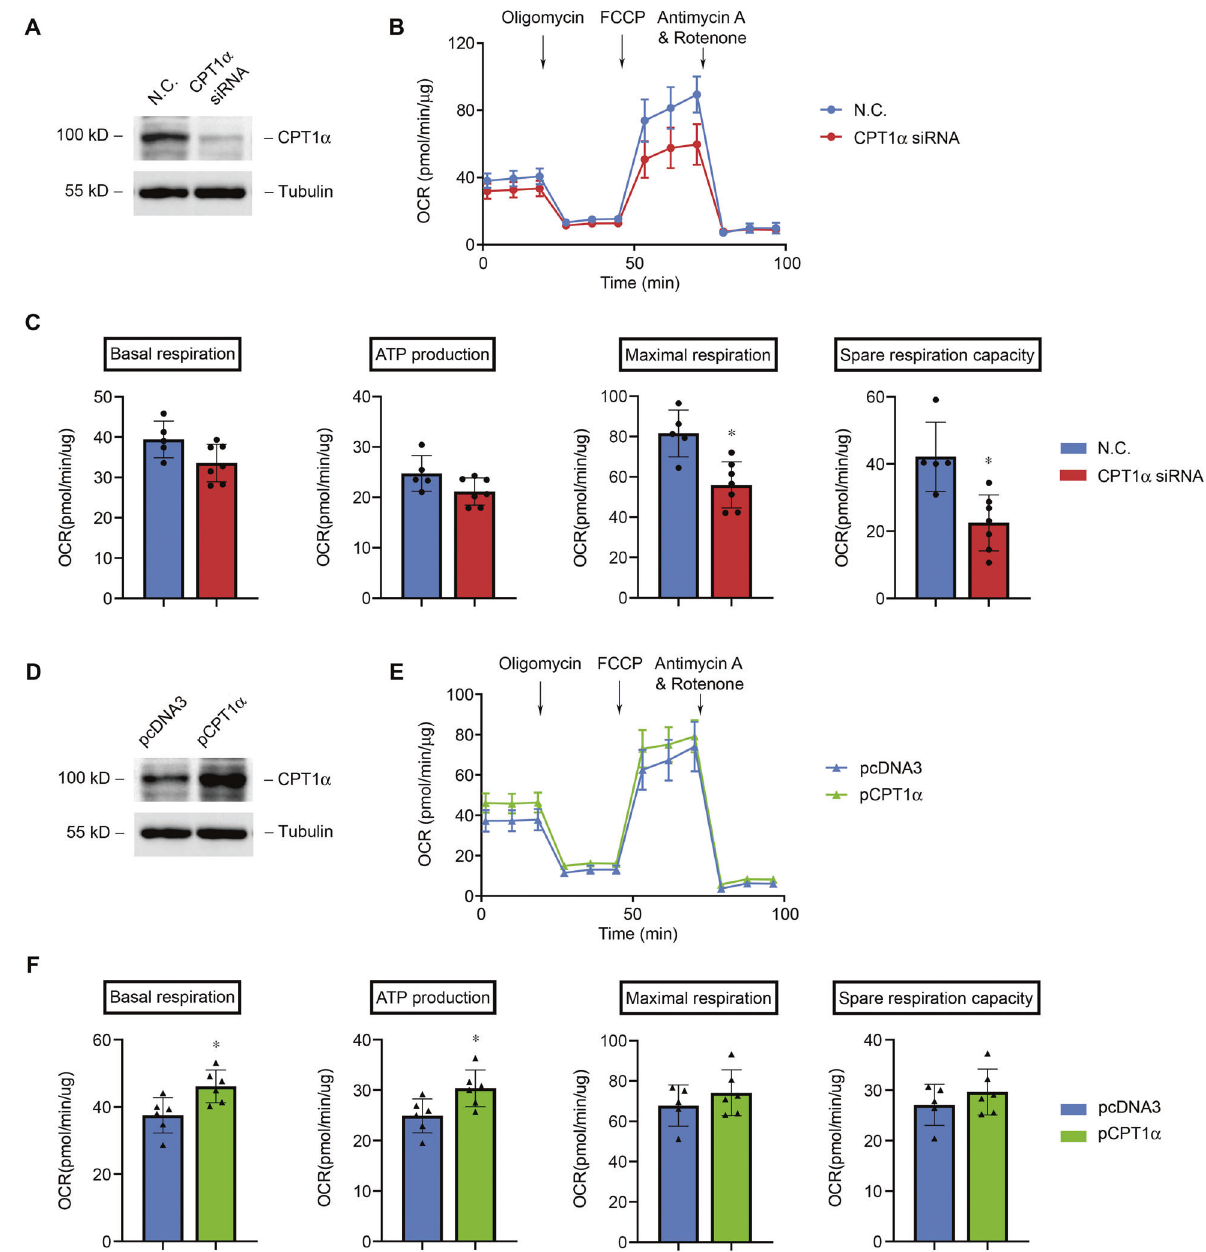
Fig. 6 CPT1 α regulates respiration and ATP production in cultured tubular epithelial cells. A Western blot analysis of protein expression of CPT1 α in cultured tubular cells after transfection with N.C. or CPT1 α siRNA. B Representative traces show OCR in tubular cells. C Summary OCR data from 5 to 6 independent experiments are shown. * P < 0.05 versus N.C. D Western blot analysis of protein expression of CPT1 α in cultured tubular cells after transfection with pcDNA3 or CPT1 α plasmid. E Representative traces show OCR in tubular cells. F Summary OCR data analyzed from 5 to 6 independent experiments are shown. * P < 0.05 versus pcDNA3. One μ mol/L Oligomycin, 0.75 μ mol/L of FCCP, 1 μ mol/L of antimycin A and rotenone were added where